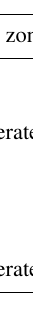
Table 4. SEM Micrographs of thr inserts showing wear at different length of cuts. Cut length After 37.5mm After 75mm End of useful tool life Cond.